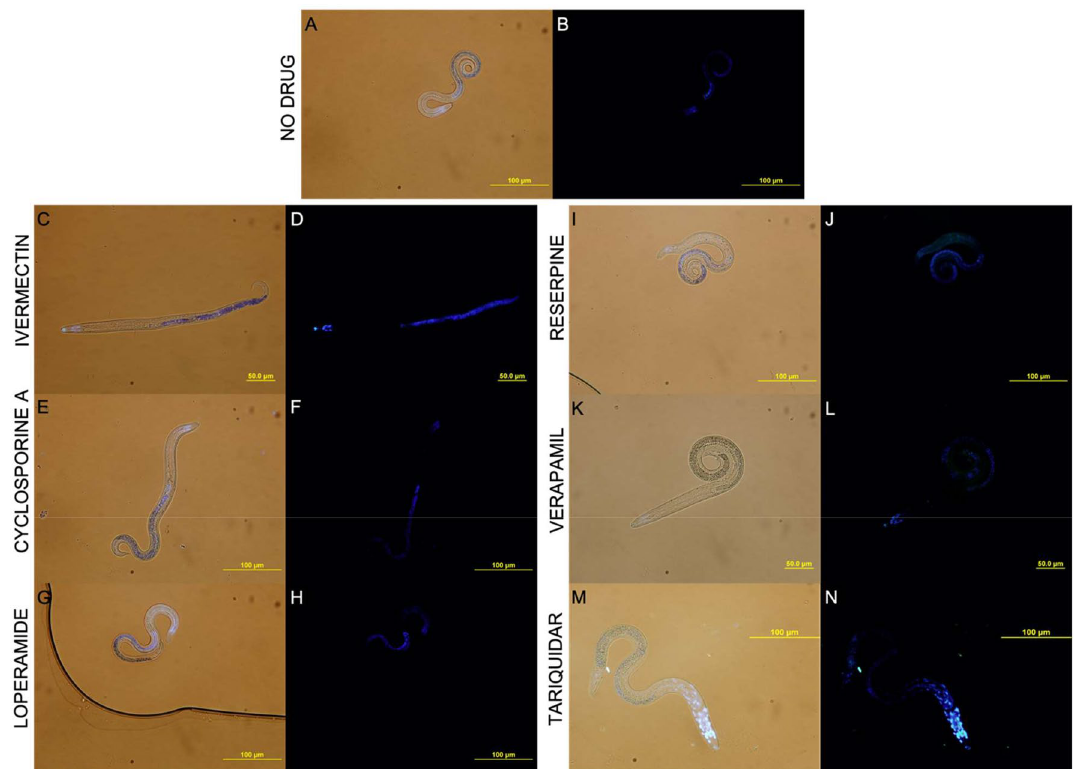
Figure 2. Representative bright-field overlays and fluorescence images of T. canis larvae stained with Hoechst 33,342 in the absence of drugs ( A , B ) and presence of inhibitors-ivermectin ( C , D ), cyclosporine A ( E , F ), loperamide ( G , H ), reserpine ( I , J ), verapamil ( K , L ) and tariquidar ( M , N ) (400x). The brightfield image was used to annotate the outline of the larvae which was overlaid on the fluorescent image. The area stained was quantitated using image analysis software (Fig.